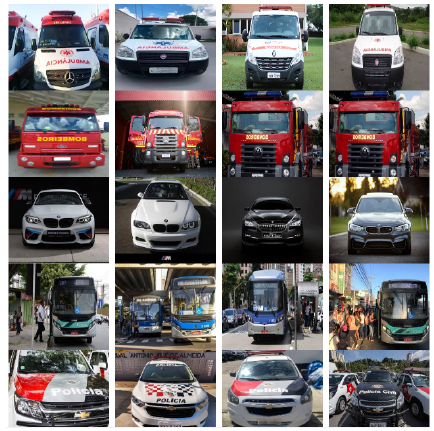
Figure 4. Database images created and their subcategories (front).